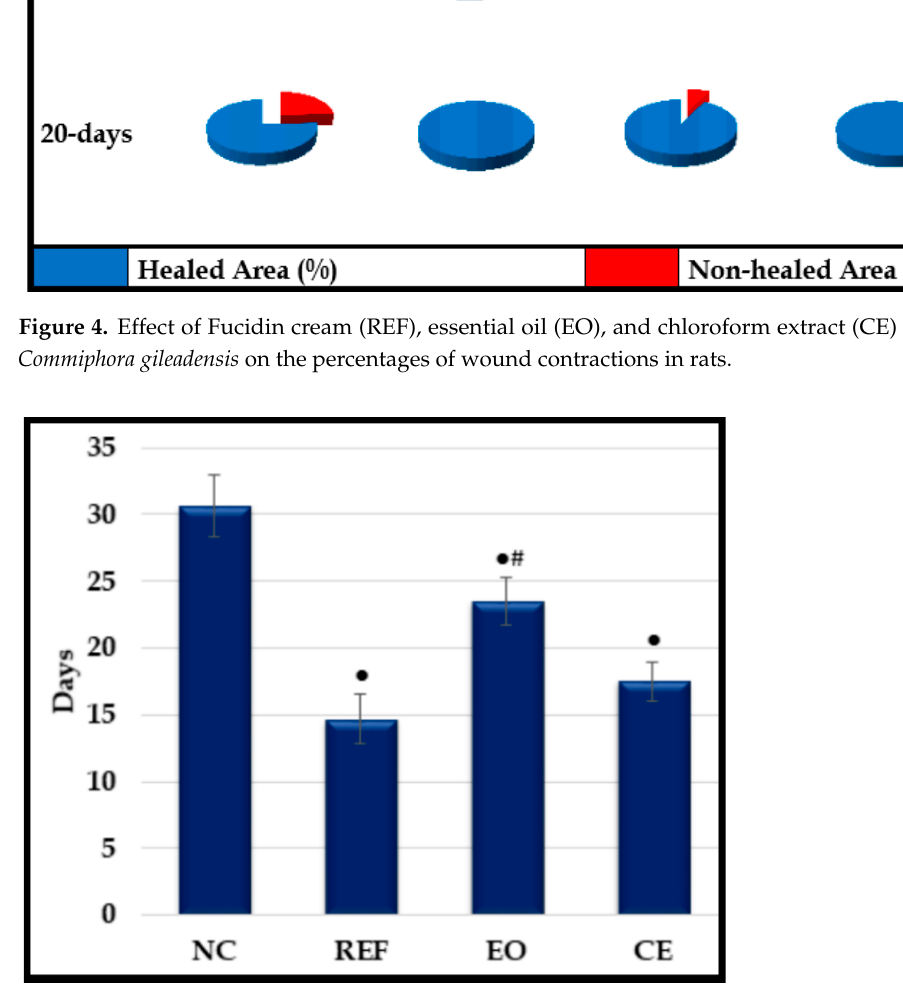
Figure 5. Effect of Fucidin cream (REF), essential oil (EO), and chloroform extract (CE) creams of Commiphora gileadensis on the epithelialization periods in rats. Values are expressed as mean ± S.E.M., n = 6 animals/group. • Significant compared to NC group at p < 0.05. # Significant compared to REF group at p <